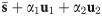
Skull variants along the two principal components with the largest eigenvalues.We visualize s¯+α1u1+α2u2, where αi = ai ⋅ σi, i = 1, 2, is the weight containing the standard deviation σi to the corresponding eigenvector ui, and the factor ai ∈ {−2, 0, 2}.